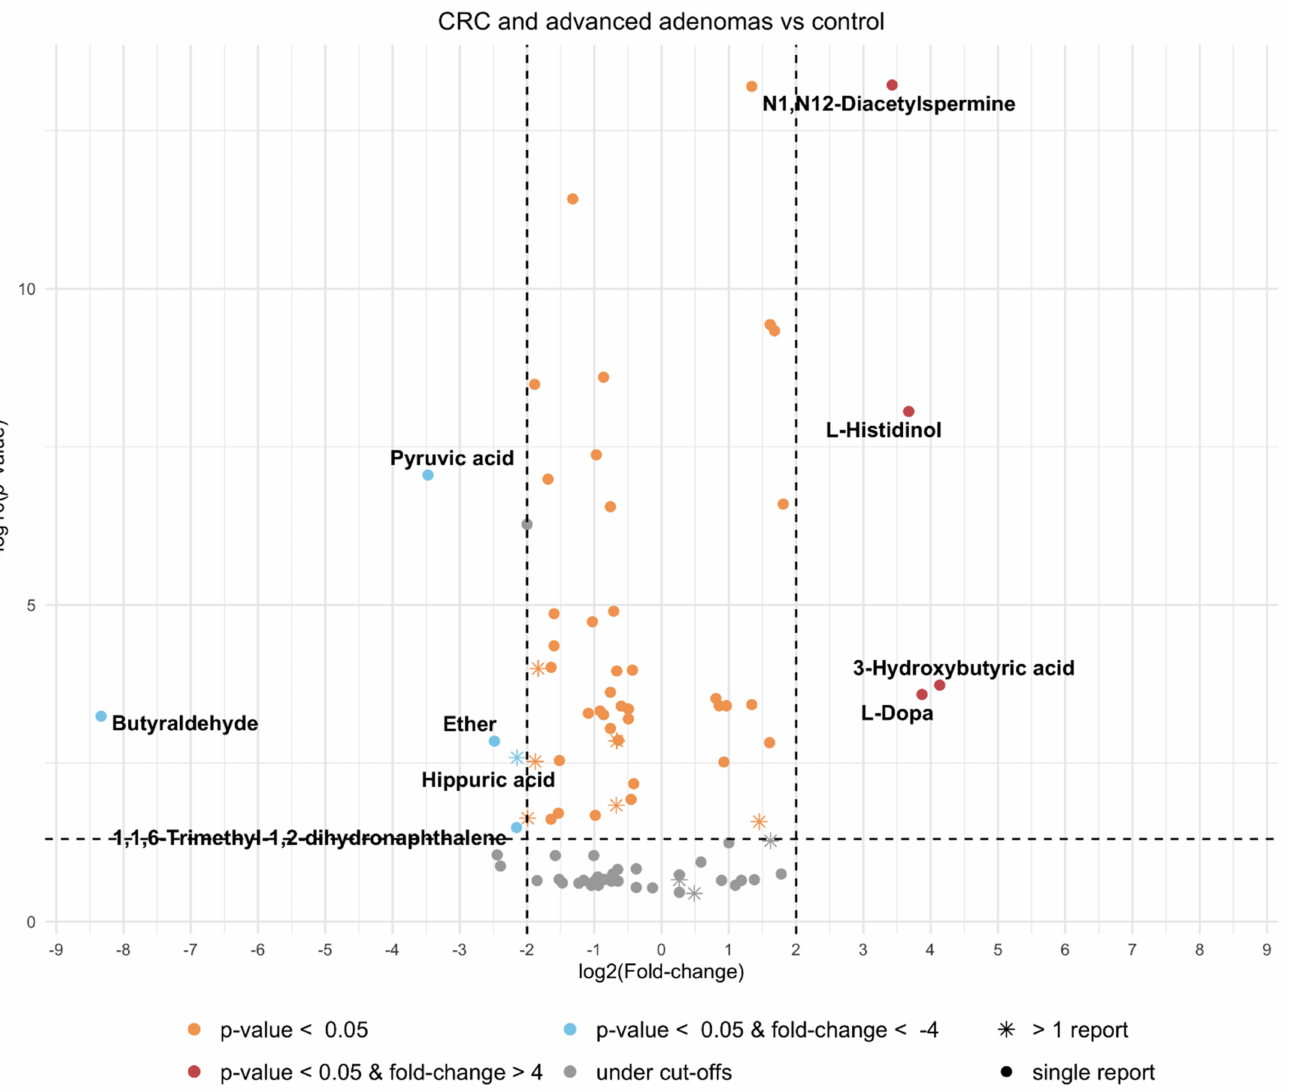
Figure 5. Volcano plot of compounds with consistent classification from meta-analysis on colorectal cancer and advanced adenomas vs. controls comparison. (cid:107) Indicates the compound was found in more than one